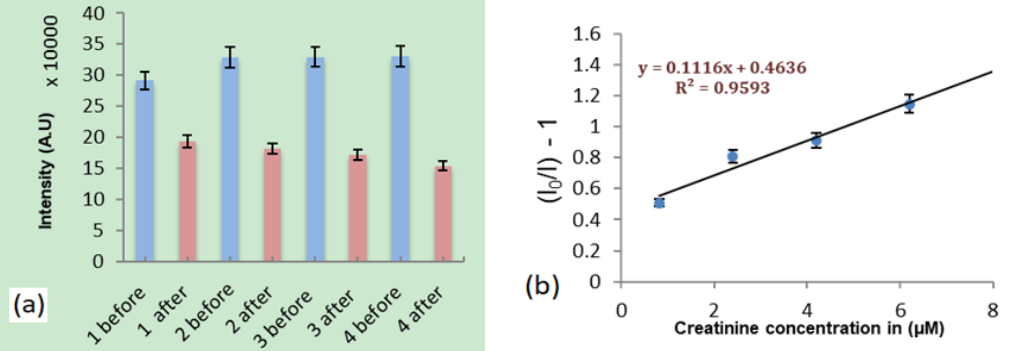
Figure 6. ( a ) Comparison of peak nanodiamond fluorescence intensity (around 700 nm) for molecularly imprinted polymer before and after the addition of four different creatinine concentrations. ( b ) Stern-Volmer plot generated from the data.